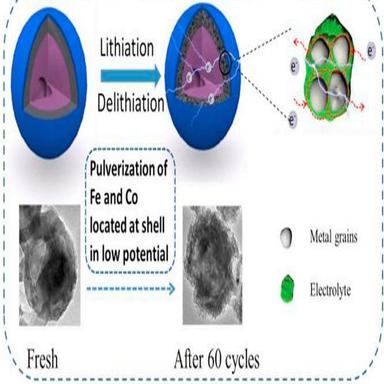
Schematic illustration of electrochemical process of Fe@CoFe2O4@C electrode after cycled.